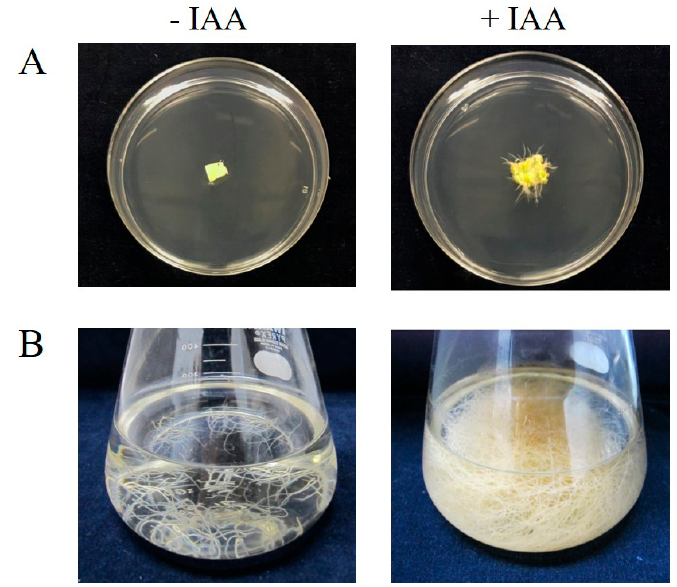
Figure 1. Root induction by IAA on MS solid and liquid media. ( A ) Leaf of transgenic GCase-producing N. benthamiana before (left) and after 4 weeks (right) of culture on an MS agar plate supplemented with IAA (1 mg/L). ( B ) Roots of transgenic GC-producing N. benthamiana cultured in MS liquid medium supplemented with IAA (1 mg/L) before (left) and after (right) 4 weeks of cultivation. The experiment was performed in triplicate .